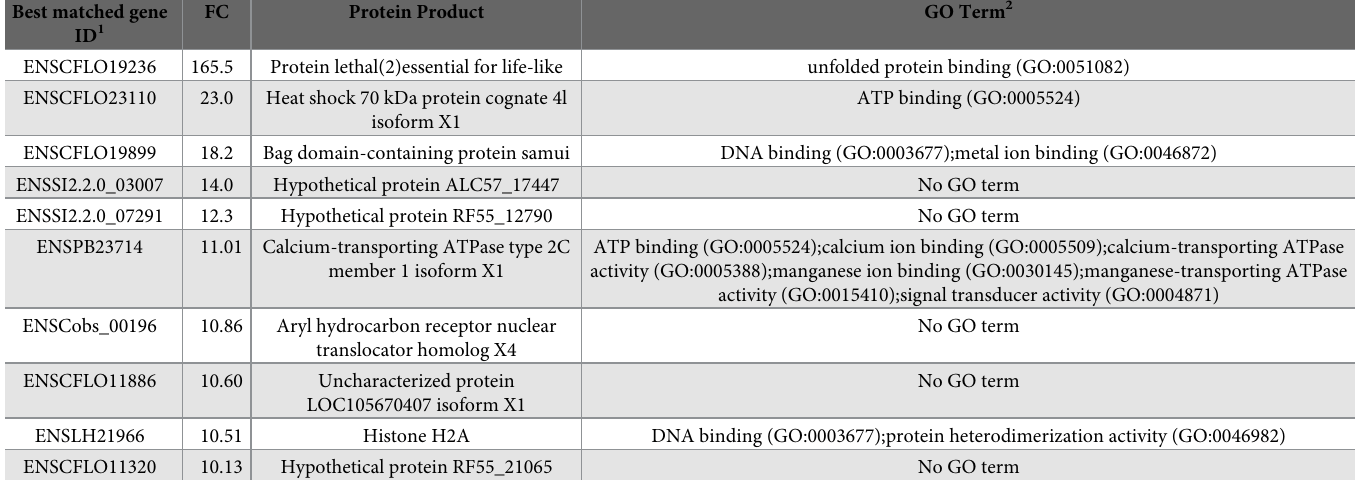
Table 1. Proteins that were strongly upregulated after heat stress in P . imparis .